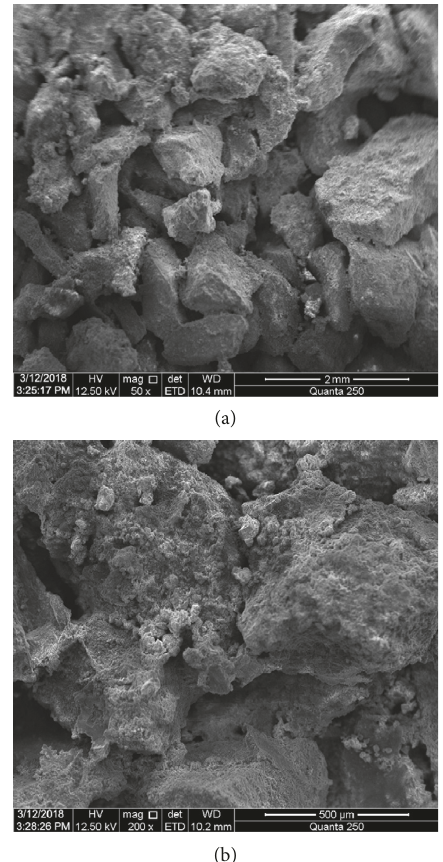
Figure 6: SEM images of the sand sample after experiment ((a) 50x; (b)